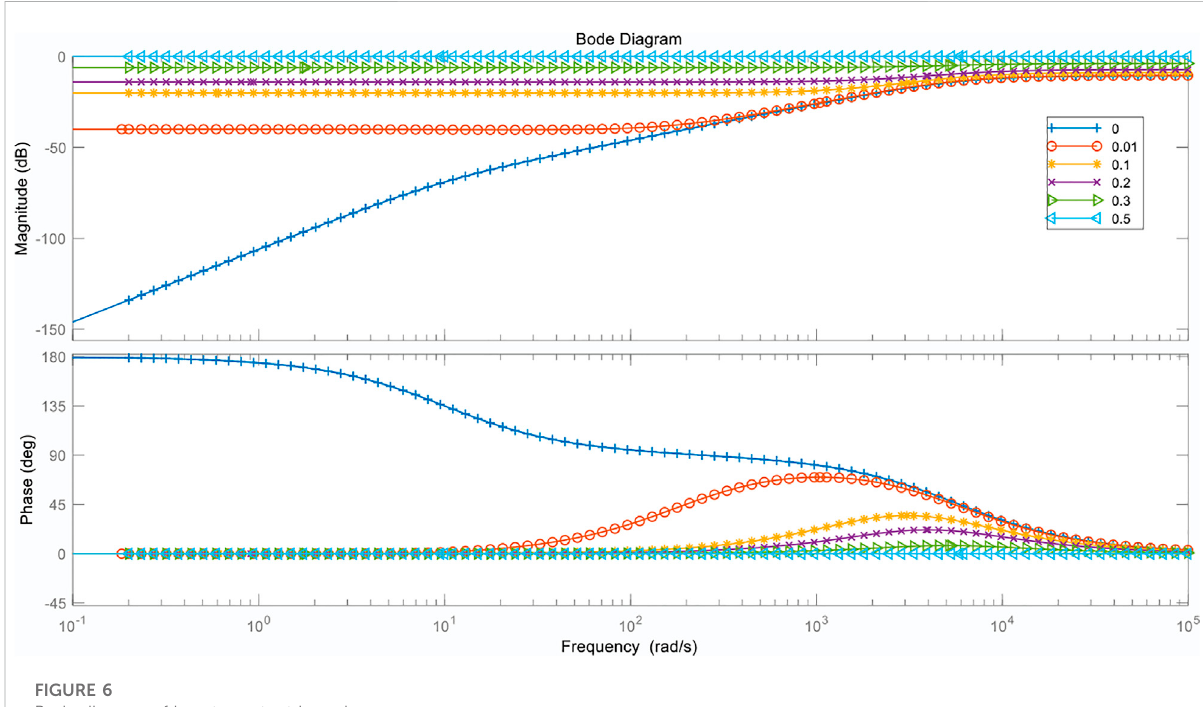
FIGURE 6 Bode diagram of inverter output